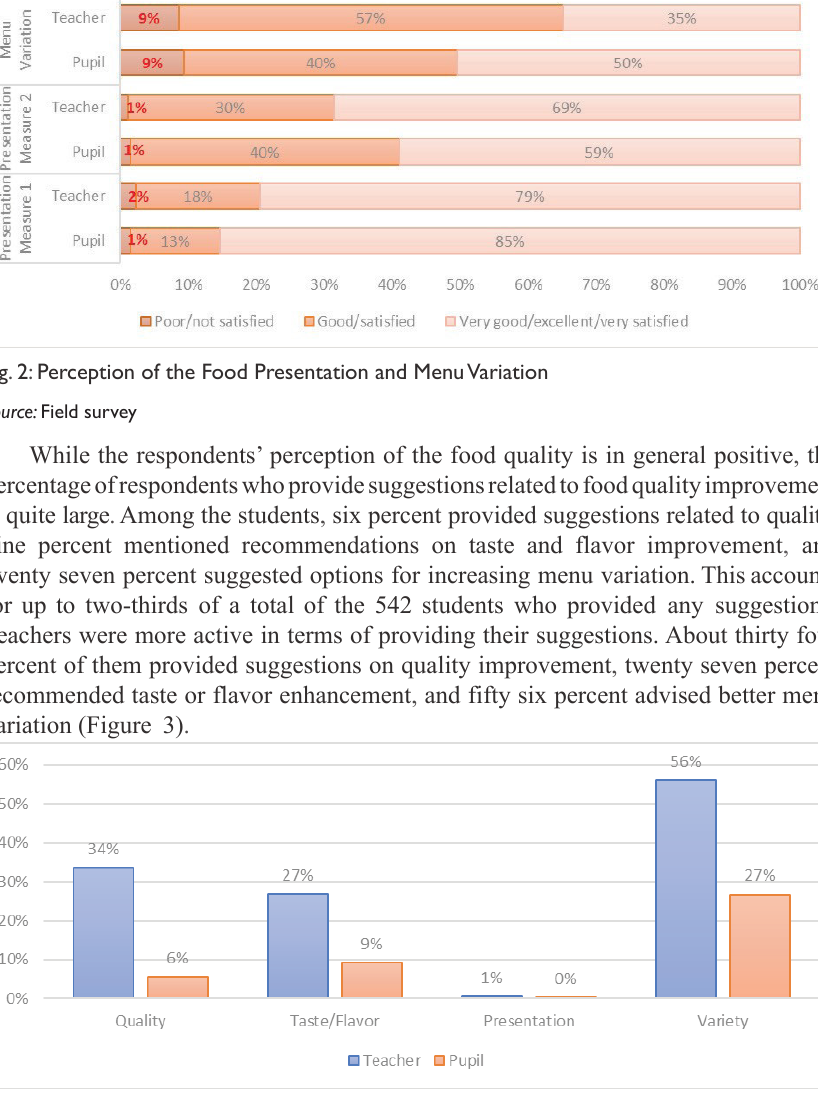
Fig. 3: Percentage of Students and Teachers Giving Quality Improvement Suggestions Source: Field